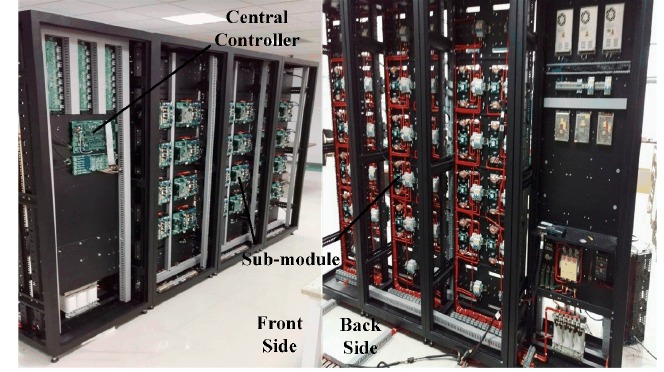
Figure 10. Experimental platform of three-phase flexible group converter.